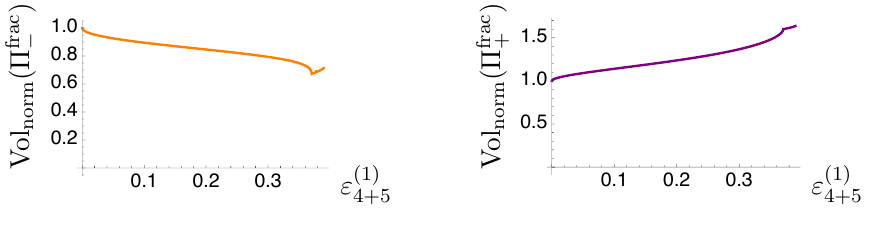
(1) bulk (cid:6) ( (cid:15) (1) = (cid:5) as a function of the 4 + (cid:15) 5 ) (cid:6) 2 = Z 6 (1)